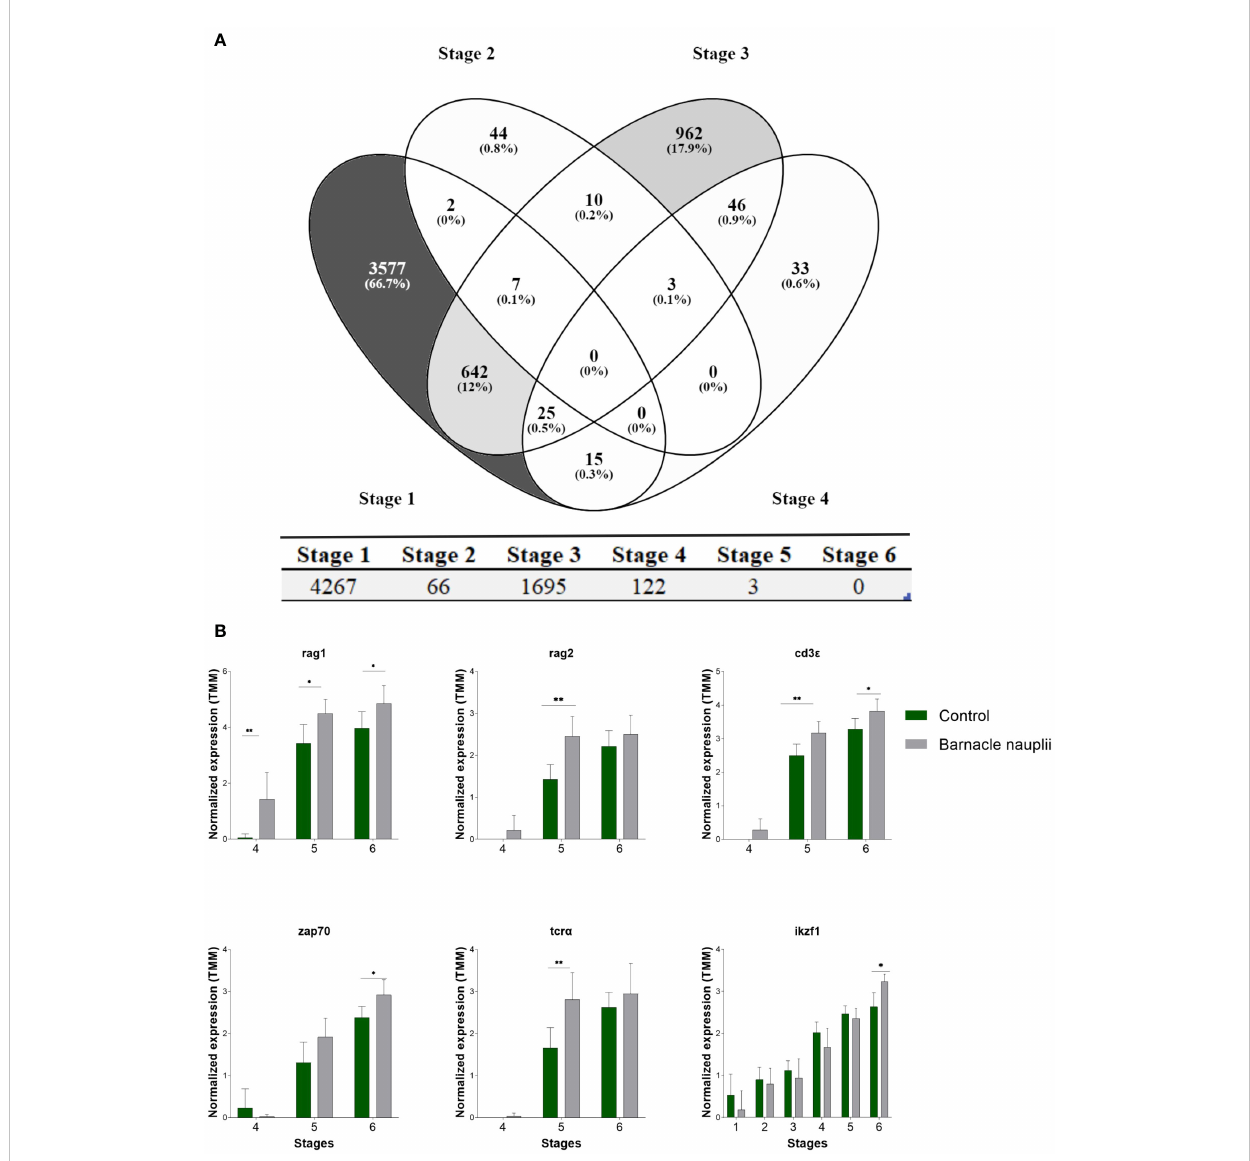
FIGURE 9 Effect of the start-feed diets on the transcriptome of ballan wrasse larvae at different developmental stages. (A) Venn diagram showing differentially expressed genes (q <0.05) in the fi rst four larval stages triggered by diets (above panel). The total number of differentially expressed genes within each developmental stage (stage 1 to 6) is displayed below. (B) T-cell markers that were signi fi cantly affected by diets. Data correspond to transcription levels that were logarithm converted, normalized for differences in library size applying weighted trimmed mean expression ratios (trimmed mean of M values (TMM)), and presented as mean = 0, ± SD (n=3). When P ≤ 0.05 signi fi cances are represented by * and when P ≤ 0.01 signi fi cances are represented by